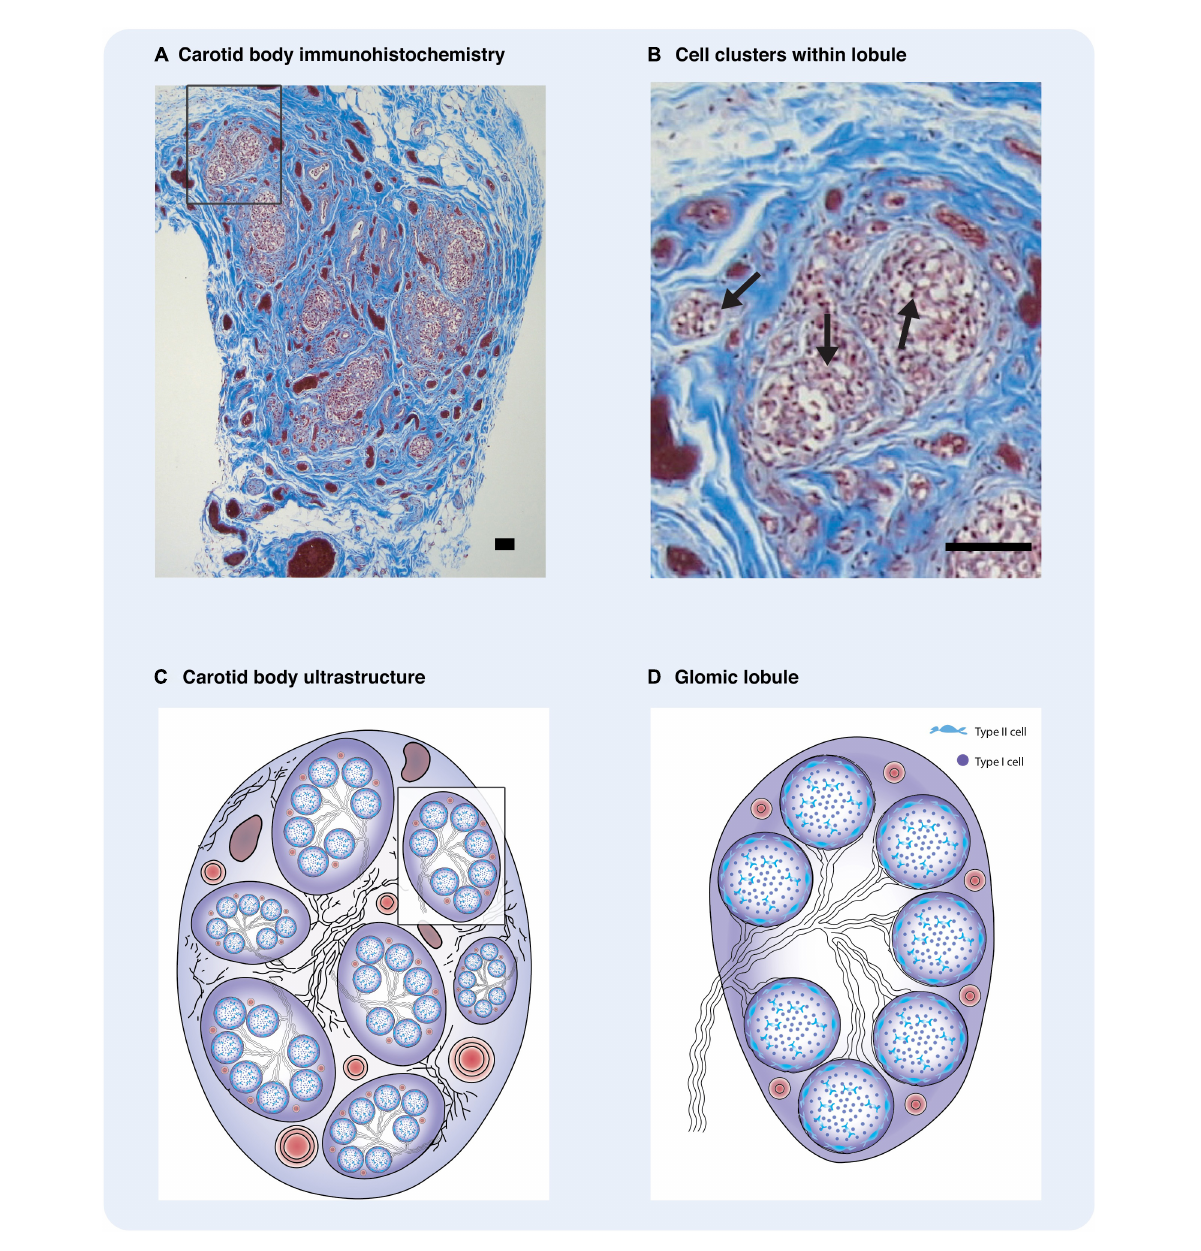
FIGURE1 Carotid body ultrastructure is highly organized. (A) Immunohistochemistry of human carotid body with Masson Trichrome stain depicting clusters of type I cells. (B) Carotid body regional cluster of type I cells. Often type I cells are arranged in smaller clusters within each lobule. (A,B) were provided to us by Dr. Rexson Tse from ADHB. (C) Diagrammatic representation of the carotid body and its constituents. Regional clusters or lobules are defined. Between the lobules are numerous bundles of myelinated nerves, glomic arteries, and veins, embedded in a fibrous capsule. (D) Diagrammatic illustration of a glomic lobule. The cluster is composed of cellular clusters, with a central core of type I cells surrounded by type II cells. Some myelinated nerves enter the lobules and branch between the clusters. These defined regions are supplied by intra-lobular glomic arterioles which terminate as capillaries adjacent to type I cells. (C,D) adapted and reproduced with permission from Heath and Smith (2012). Arrows – type I glomus cells. Scale bars –20 µ